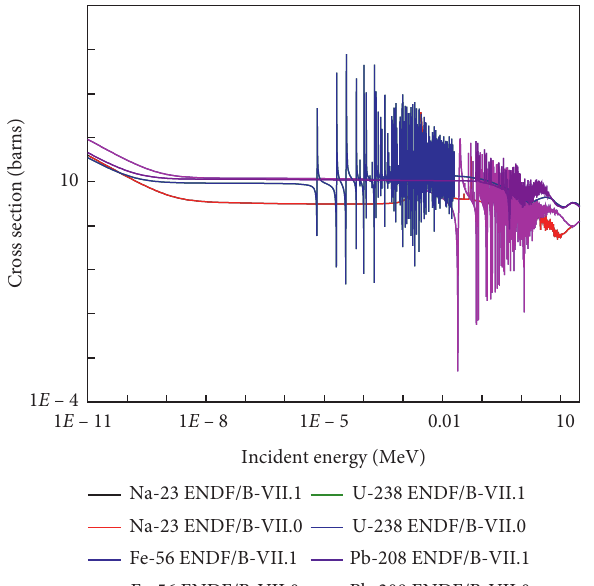
to 235 U capture eff